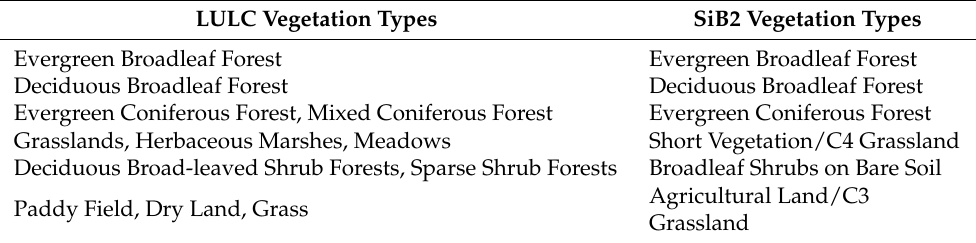
Table A2. Mapping between LULC vegetation types and SiB2 vegetation